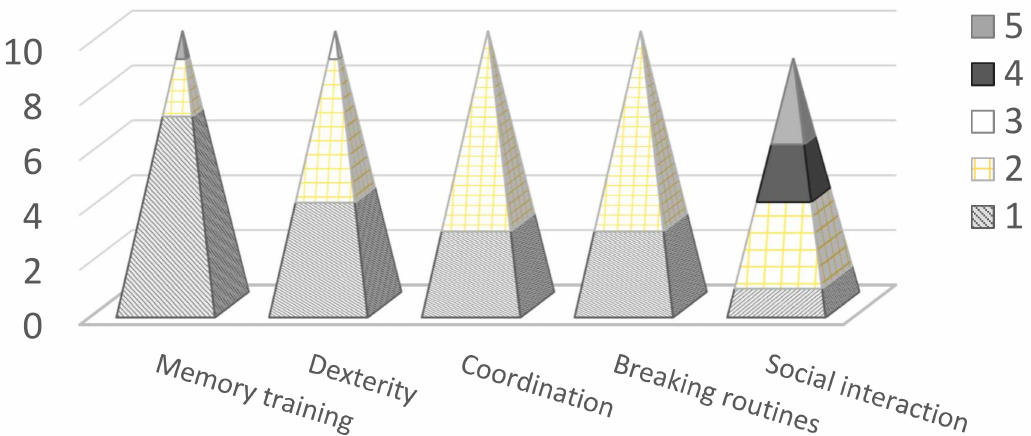
Figure 3. Results from the participant interviews in China (10 elderly players): The benefits of mobile gaming on different areas of their lives on a scale of 1–5, where 1 is “very beneficial” and 5 is